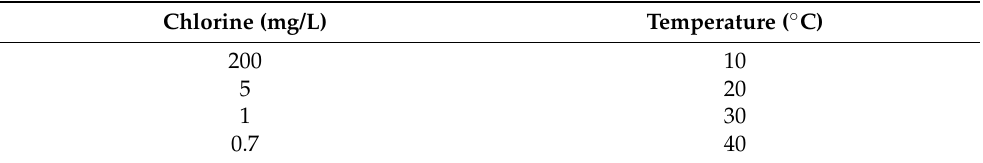
Table 4. Maximum operating temperatures for superduplex stainless steel as a function of chlorine content [51].